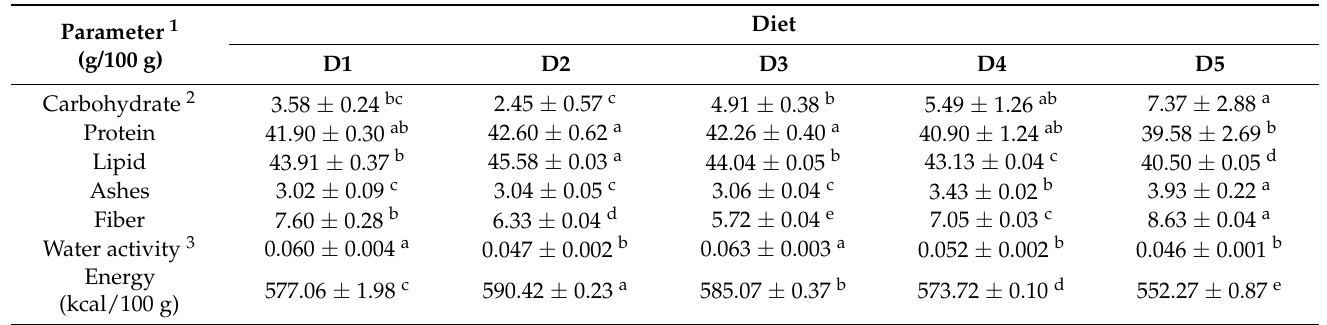
Table 3. Physicochemical characterization of Zophobas atratus larvae fed with a conventional diet with or without grape residue for 90